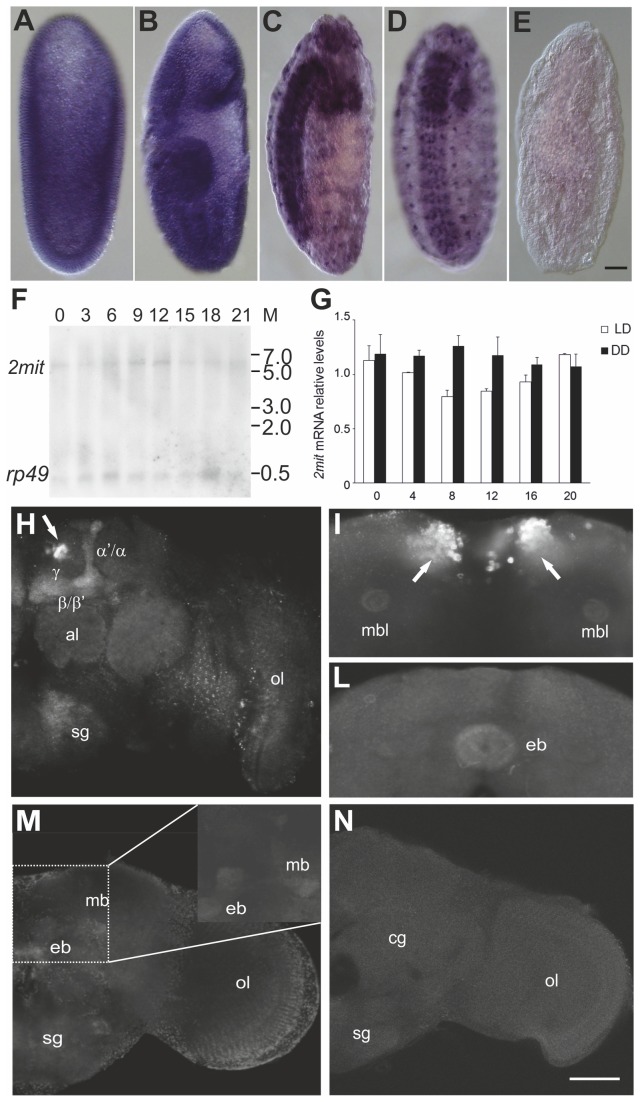

2mit mRNA expression in w
1118 flies.(A-D) Embryos at different developmental stages hybridized with the antisense 2mit probe. (A) Stage 5. (B) Stage 9. (C-D) lateral and frontal views of stage 15. (E) Negative control showing a stage 15 embryo hybridized with the 2mit sense probe. Bar in (E) represents 25 µm for (A)-(E). (F) Northern blot from wild-type adult heads sampled every 3 h in 12:12 LD conditions. 2mit indicates the single 2mit transcript revealed in adult heads. rp49 represents the rp49 housekeeping mRNA. M: RNA Ladder molecular marker. (G) 2mit mRNA levels [mean ± standard error of the mean (SEM)] sampled every 4 h in 12:12 LD (white bars) and DD (black bars) conditions. For each condition, 3 replicates were performed. In 12:12 LD, significant variations in 2mit mRNA levels were detected (F5,10=7.89, p <0.01). In DD, no significant modifications in 2mit mRNA levels were detected (F5,12= 0.56 p= 0.76). (H-N) 2mit mRNA localization in whole-mount adult brains sampled at ZT 0. (H-L) Wild-type adult brains hybridized with the 2mit antisense probe. (H) 2mit mRNA signals are visible at the level of the Kenyon cells (arrow) and in the different lobes of the MBs (image shows a ~6 µm Z-projection along the antero-posterior axis). (I) and (L) ~5 µm Z-projections obtained from the same brain showing 2mit mRNA signals in the Kenyon cells (arrows; I) and in the EB (L). (M) 2mit
c03963 adult brain hybridized with the 2mit antisense probe. Weak signals are detected in the MB lobes and EB. (N) Wild-type adult brain hybridized with the 2mit sense probe (negative control). (M) and (N) are ~10 µm Z-projections. The following abbreviations are used: ol: optic lobe; al: antennal lobe; mb: mushroom bodies; mbl: mushroom bodies lobes; eb: ellipsoid body; sg: subesophageal ganglion; cg: central ganglion. α/ α’: vertical mushroom bodies lobes; β, β’, γ: medial mushroom bodies lobes. Bar in (N) represents 50 µm for (H), (M) and (N), and 25 µm for (I), (L), and the 2X magnification inset in (M).